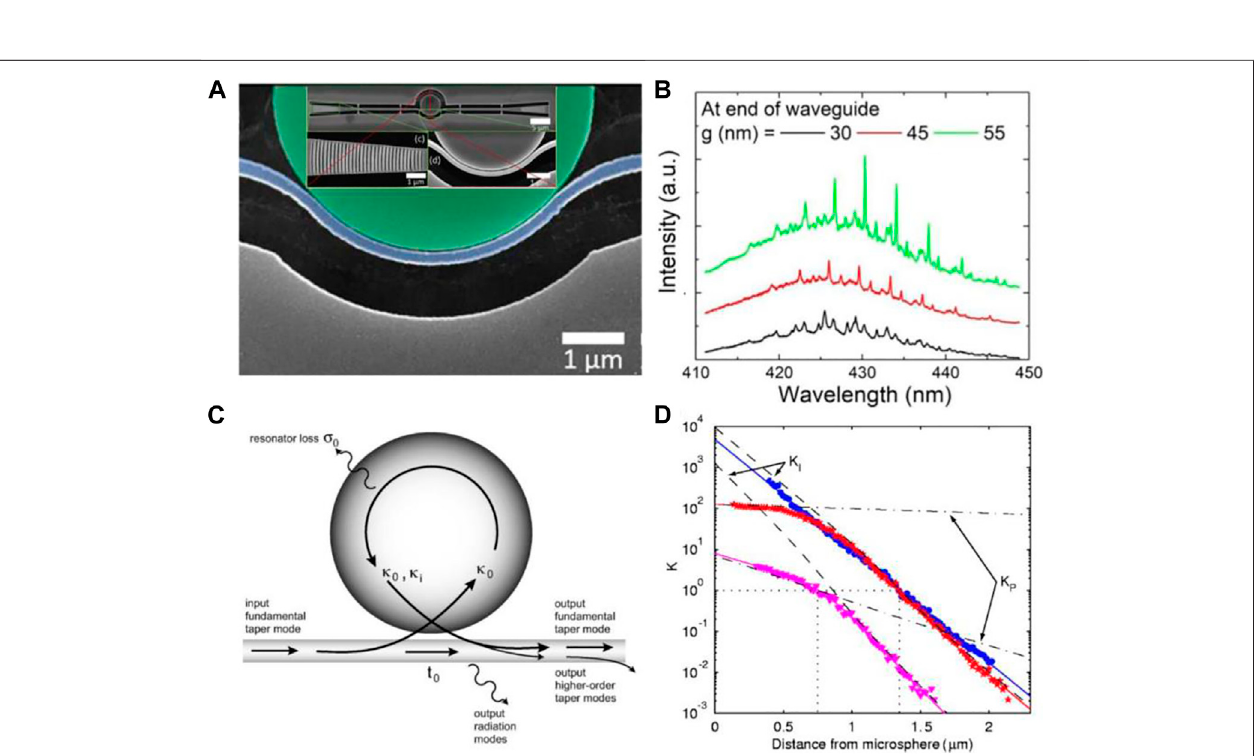
FIGURE10|(A) Couplingstructureinanactive GaNmicrodisk laserwithbuswaveguideonanSisubstrate. (B) Lasingspectraofcoupled structures withdifferent coupling distances (Tabataba-Vakili et al., 2019). (C) Schematic diagram of the waveguide coupled with a microcavity. (D) Relationship between the coupling distance and the coupling coef fi cient (Spillane et al., 2003). Reprinted with permission © APS Physic Publishing (Spillane et al., 2003).